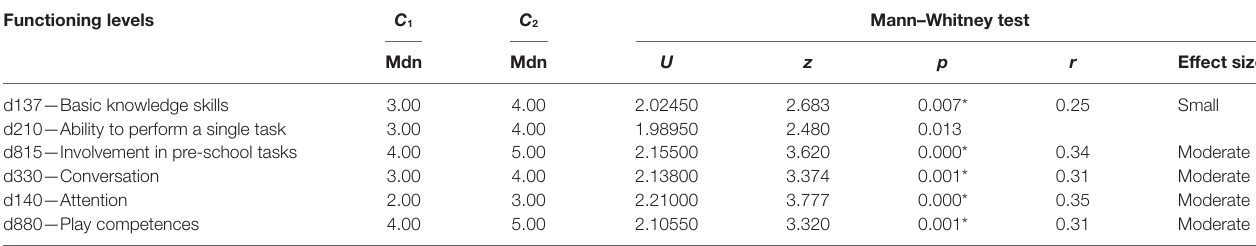
TaBle 2 | Differences between children with SEN ( C 1 ) and children without SEN ( C 2 ) regarding levels of functioning in the 6 ICF-CY Developmental Code Sets. Functioning levels